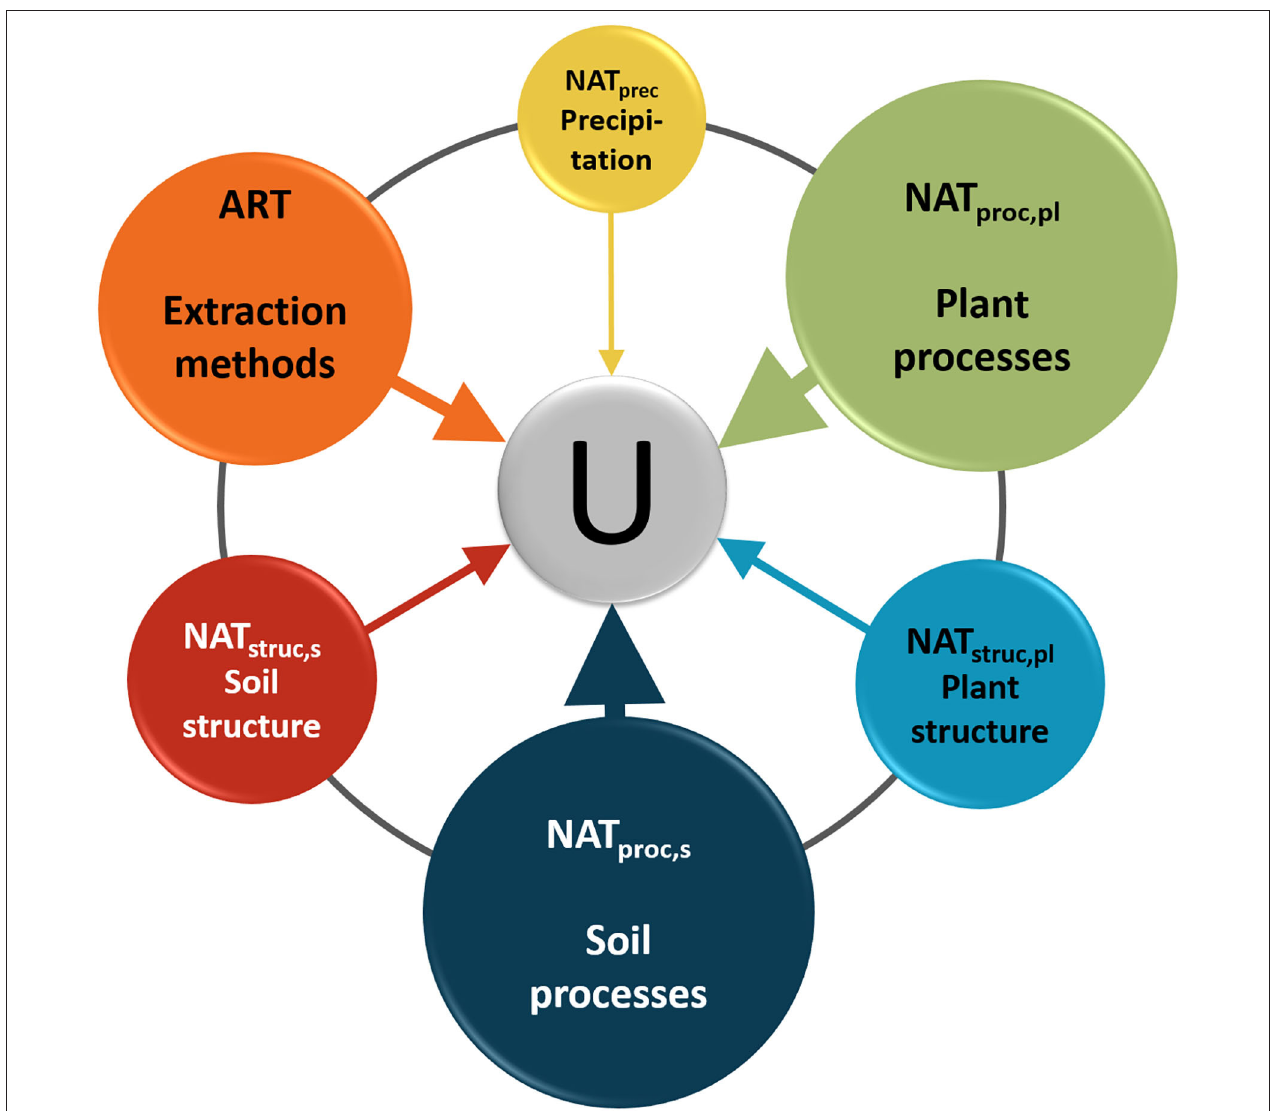
FIGURE 1 | Schematic conceptual representation of the natural ( NAT ) and artificial ( ART ) effects that cause uncertainty ( U ) in isotope-based estimates of plant water sources. NAT prec refers to point (1a) listed in the text; NAT proc , pl refers to points (1b–d); NAT struc , pl refers to points (1e and f); NAT proc , s and NAT struc , s refer to points (1g) and (1h), respectively; and ART refers to points (2a–c). Plant and soil structure are characterized by the structural heterogeneity of ecohydrological systems, whereas plant and soil processes are characterized by the heterogeneity of the process. The dark gray line connecting all circles conceptually represents the links between all effects. Note that this line connects adjacent circles for visual clarity purposes only and that existing physical and physiological links between most of the circles (e.g., between plant structure and soil structure, between plant processes and soil processes, and between precipitation and soil structure and processes) are omitted to improve the figure readability. The difference in the size of the circles implies the subjectively estimated importance of individual effects on the combined uncertainty. NAT prec is depicted with the smallest circle despite the large spatial and temporal variability of its isotopic composition because current sampling designs and technical approaches allow capturing this variability relatively well. We are well aware that accounting for all these sources of uncertainty in isotope-based estimates of water sources used by vegetation is not possible but at least the key ones (i.e., the largest circles) should not be neglected and, if not quantified, mentioned and considered in ecohydrological